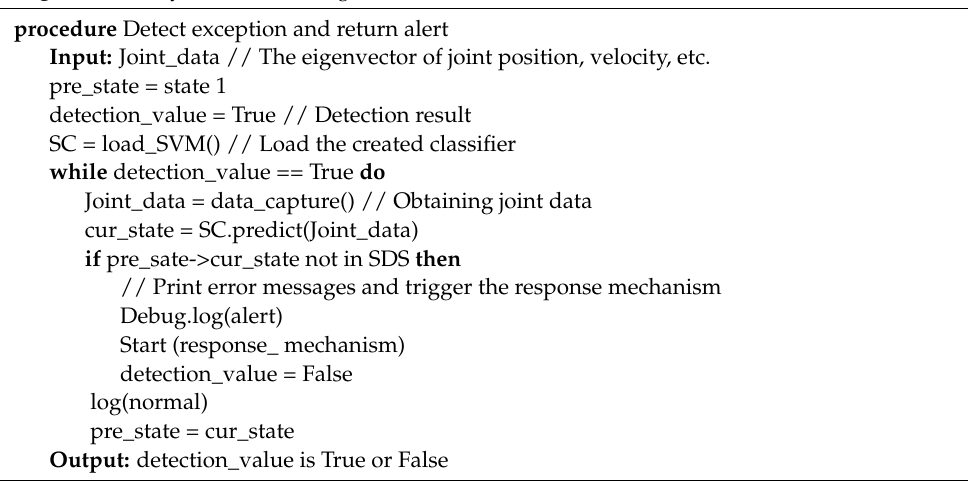
Algorithm 2 Physical Process Logic Intrusion Detection